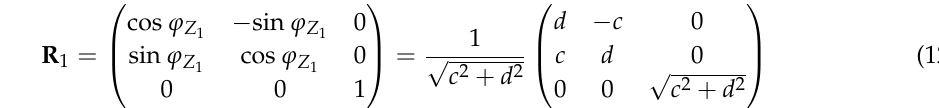
and ϕ Z . Applying 2 1